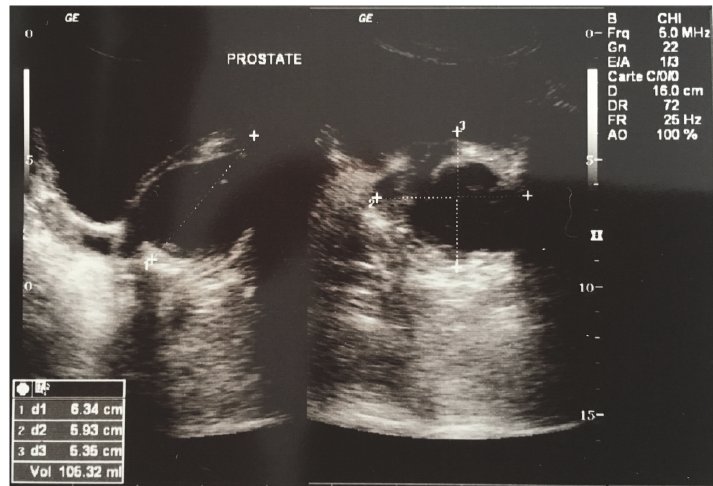
Figure 1: Abdominal ultrasound showing hypoechoic collection inside prostatic parenchyma.